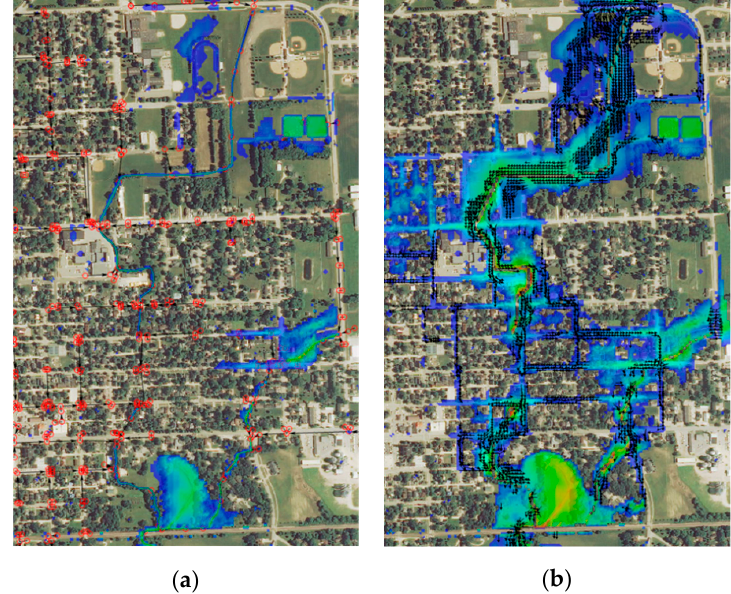
Figure 10. The maximum flood depths in Eastern Manchester for a heavy local rainfall event using the XPSWMM model where ( a ) has the stormwater system (described in Section 3.2) activated and ( b ) is overland flow only.